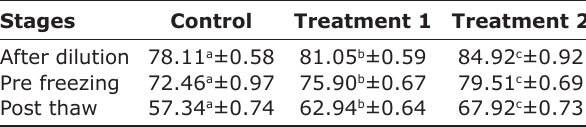
Means with different superscript letters (a, b, c) differ significantly within a row. Treatment 1=0.5 mM